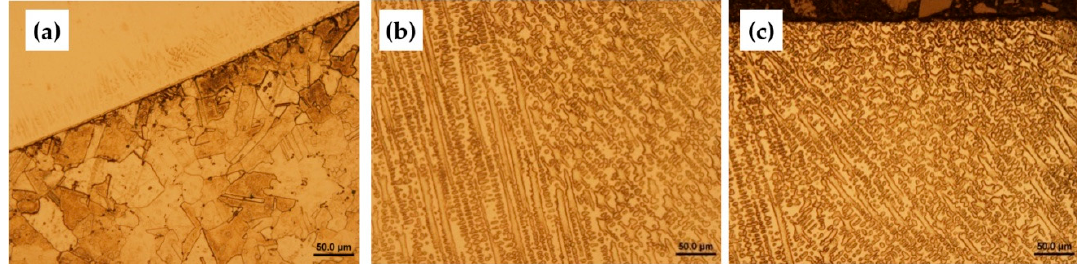
Figure 5. Microstructure of the three-layer CMT welded clad made using E Ni 6625, ( a ) fusion zone, ( b ) middle part, and ( c ) surface of the clad.